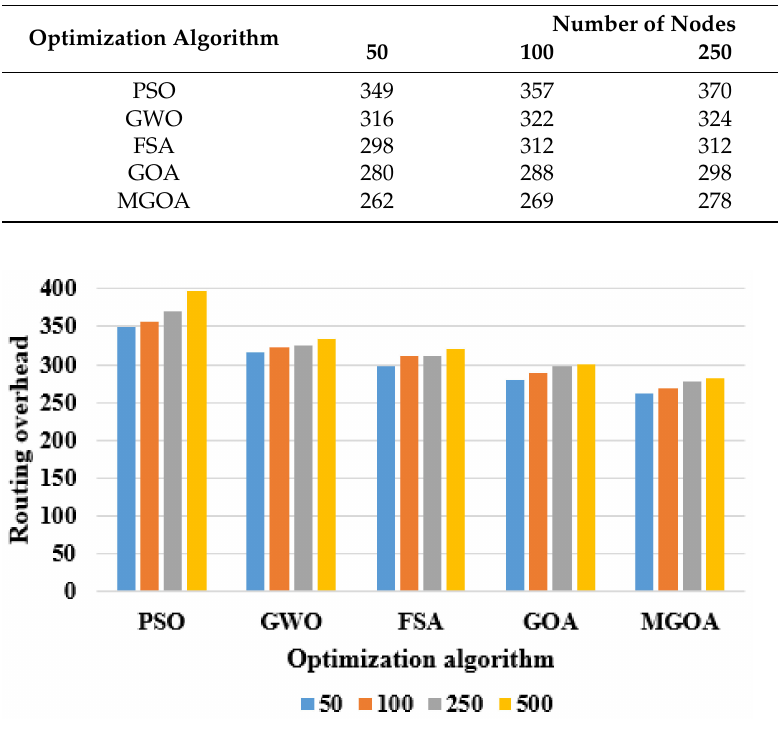
Figure 5. Graphical analysis of MGOA-WAVLCN in terms of routing overhead.